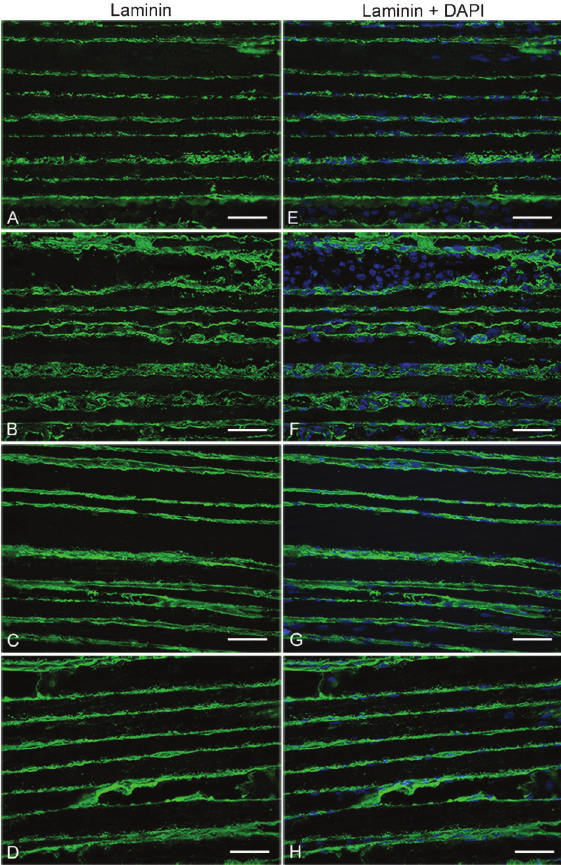
Figure 6. Photomicrographs of the soleus muscle of the animals in groups IF (3) , IS (3) , IF (10) , and IS (10) . A - H : Longitudinal sections immunolabeled with rabbit polyclonal anti-laminin (green fluores- cence) antibody, nuclear fluorescent staining defined by DAPI (blue fluorescence). A [IF (3) ] and B [IS (3) ]: Staining thickness and laminin expression in intracellular areas. C [IF (10) ] and D [IS (10) ]: Staining thickness. E [IF (3) ], F [IS (3) ], G [IF (10) ], and H [IS (10) ]: Merged images of laminin and DAPI. Observe the localization of the nuclei (in blue). See Figure 1 legend for explanation of abbreviations. Scale bars: 50 m